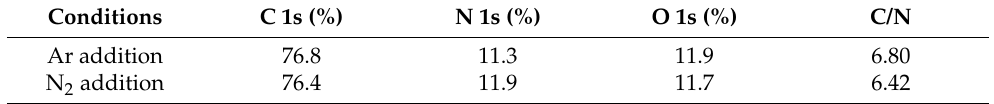
Table 1. Surface atomic composition ratios of PANI films synthesized with additional gases (Ar and N 2 ).